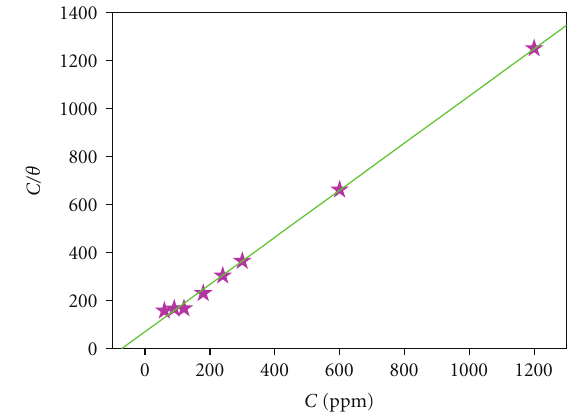
Figure 6: Langmuir adsorption isotherm plot for the adsorption of extract in 1M HCl on the surface of mild steel.